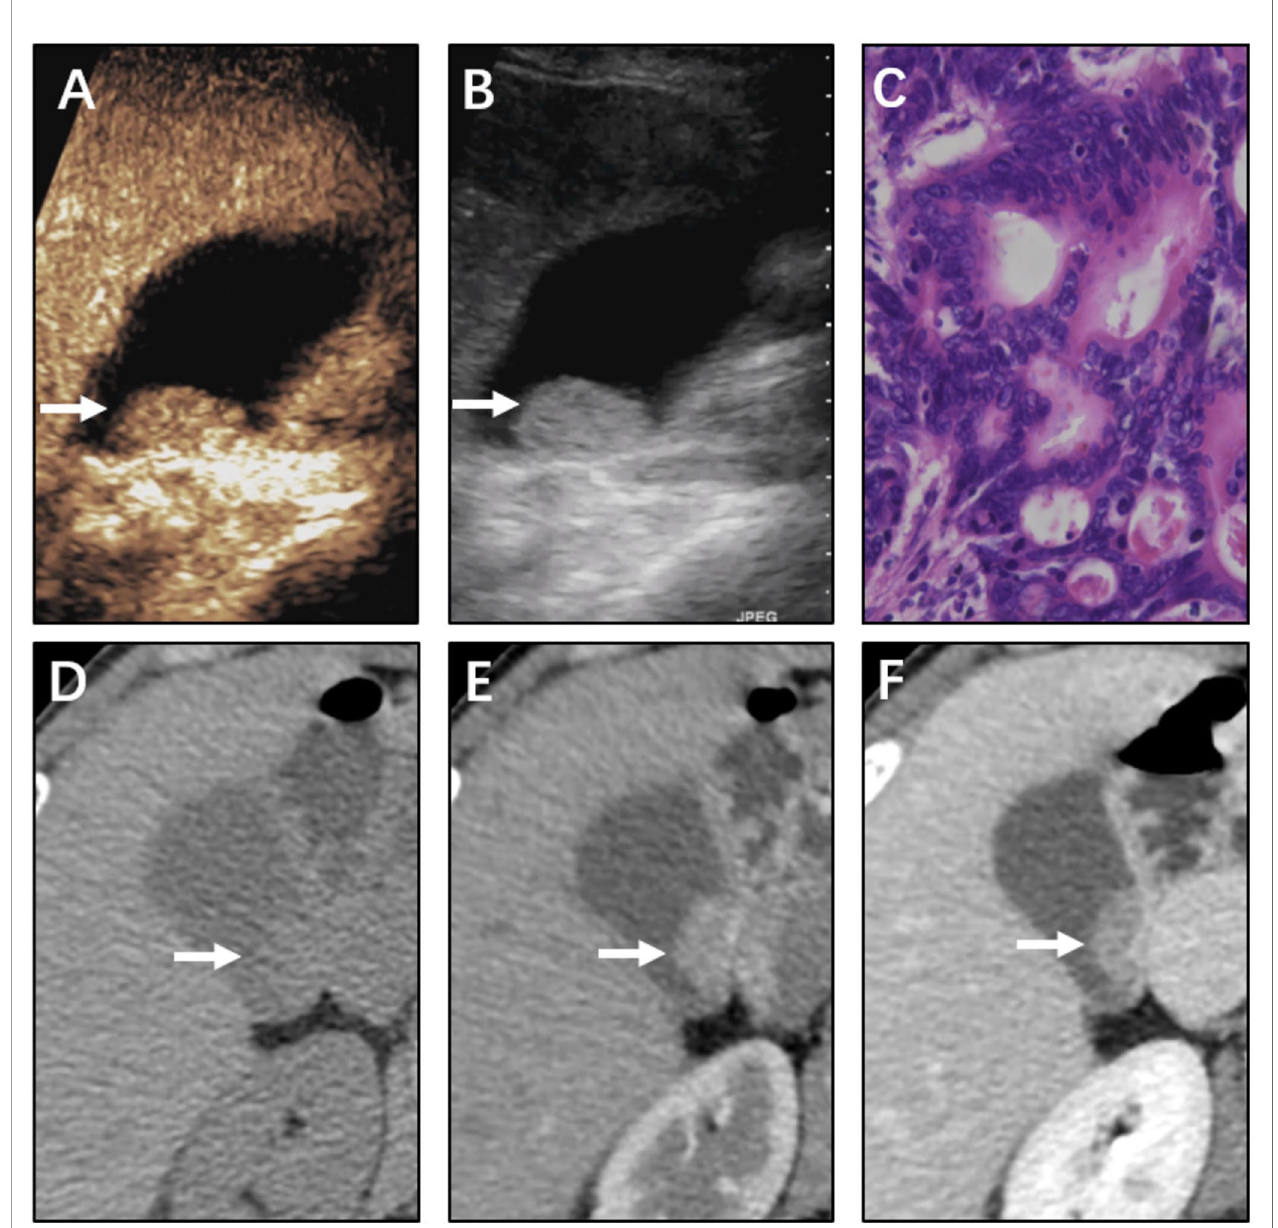
FIGURE 3 | Neoplastic polyp (adenocarcinoma) of the gallbladder in a 61-year-old woman. CEUS image (A, B) showing a 21 mm sized mass. (A) Microvascular image showing intralesional vessels with a strong and heterogeneous pattern. (B) 2D mode. (C) Histopathologic image of gallbladder adenocarcinoma. (H&E stained, original magni fi cation × 400). CT images (D – F) showing the same mass in the nonenhanced phase, arterial phase, and portal venous phase, respectively. The mass was clearly detected in the nonenhanced phase. The mass was signi fi cantly enhanced with the use of a contrast